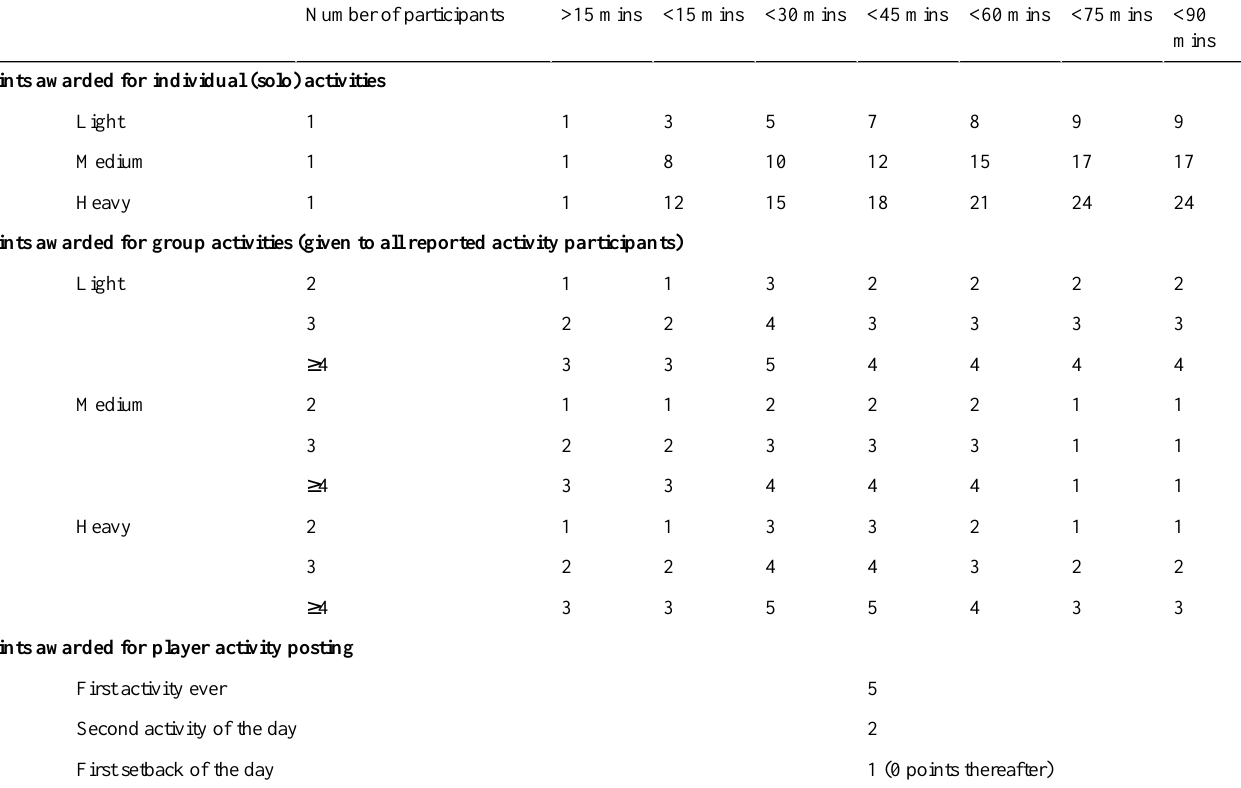
Table 5. Wellness Partners Game+Diary point reward